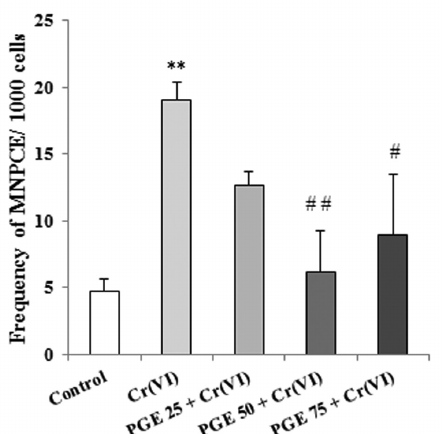
(25, 50, and 75 mg/kg/day) for 10 days on the frequency of micronucleated polychromatic erythrocytes (MNPCE) in mice exposed to a sub-lethal dose of Cr(VI) (30 mg/kg). Each bar presents mean±SD. (**p<0.01 vs. control; #p<0.05 and ##p<0.01 vs. Cr(VI). One way ANOVA and Tukey’s test, p<0.05).